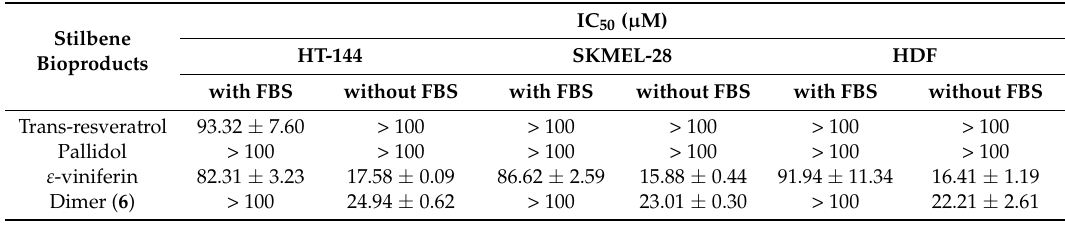
Table 1. IC 50 of bioproduced stilbenes with or without FBS in HT-144, SKMEL-28 and HDF cells at 24 h as determined by the MTT